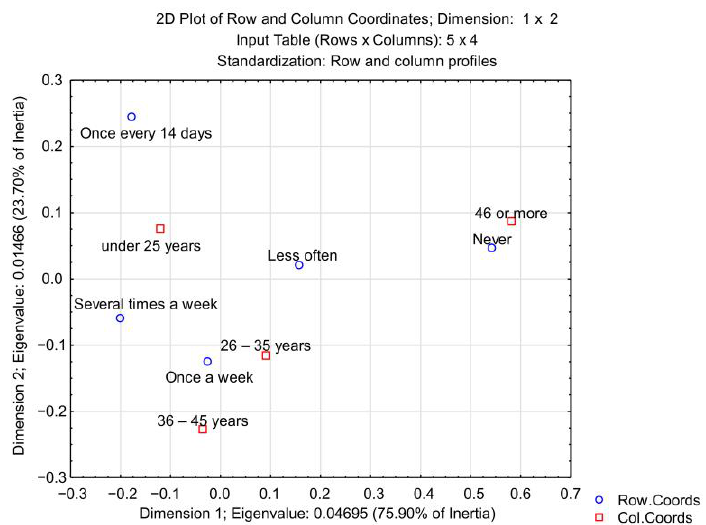
Figure 4. Correspondence maps, Supermarkets & Respondent’s age. Source: authors.